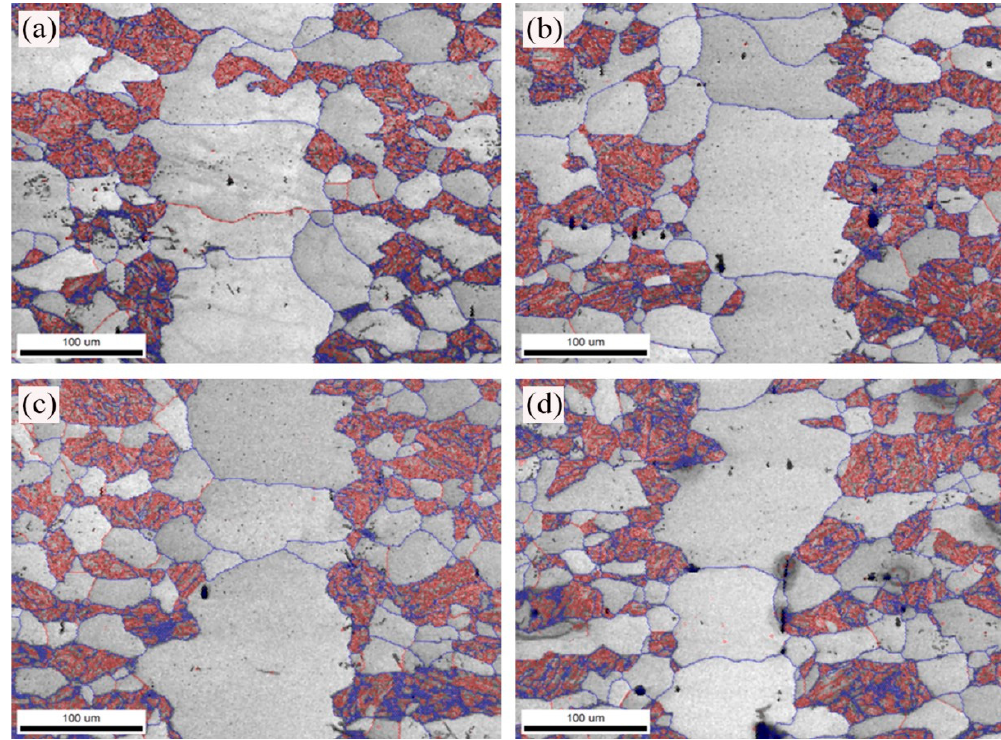
Figure 3. Grain-boundary-distribution maps of joint regions for different aging times: ( a ) 5 h, ( b ) 20 h, ( c ) 100 h, and ( d ) 500 h. (The blue lines represent the high-angle boundaries, while the red lines denote the low-angle boundaries.)